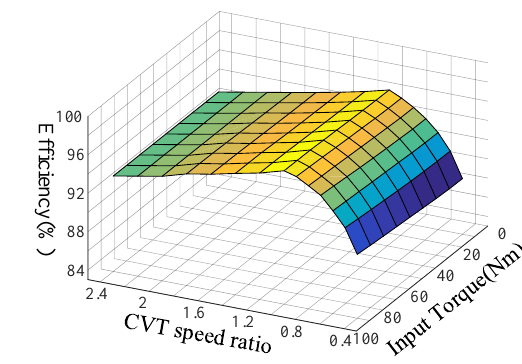
Figure 5. CVT efficiency map.